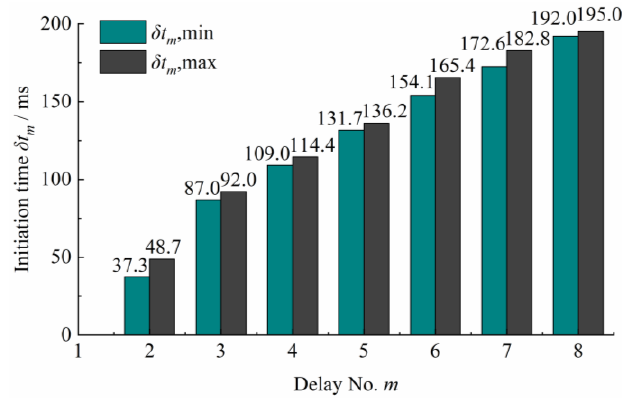
Figure 4. Initiation time range of detonators per delay.